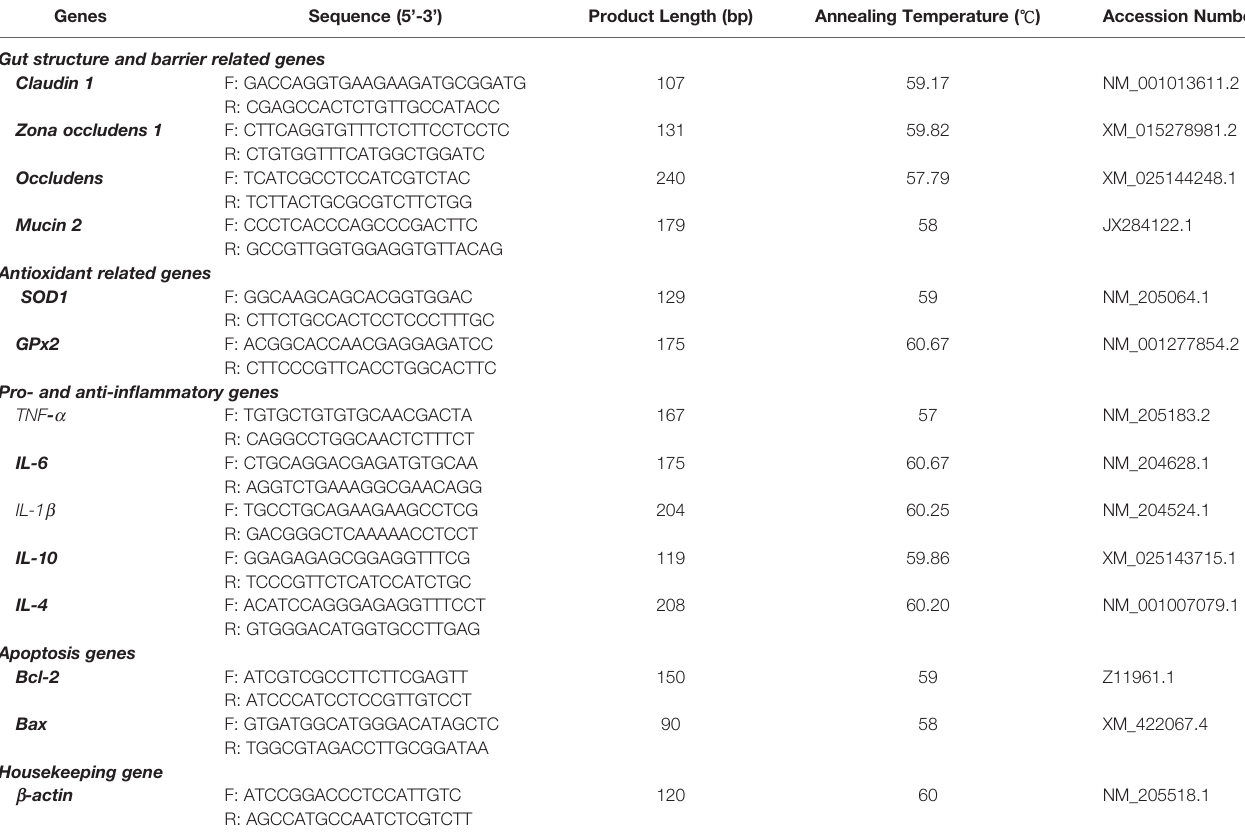
TABLE 1 | Primers used for quantitative real-time polymerase chain reaction